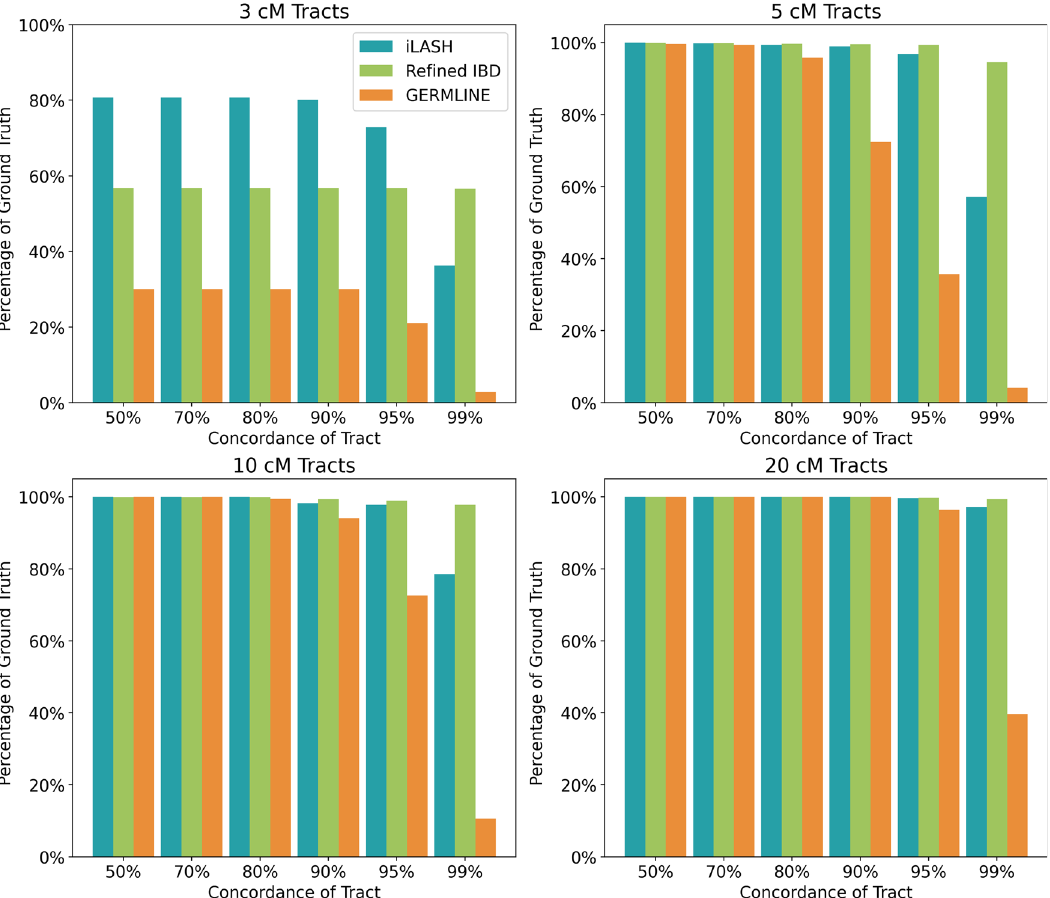
Fig. 2 Accuracy of IBD estimation tools in simulated data. Accuracy of iLASH, GERMLINE, and Re fi ned IBD on simulated data (30000 samples derived from the Puerto Rican population in the PAGE study sharing 3,660,900 IBD segments) at tract lengths of 3, 5, 10, and 20 cM and accuracies from 50 to 99%. The displayed percentages are based on the total number of IBD tracts with the speci fi ed length. Source data are provided as a Source Data fi